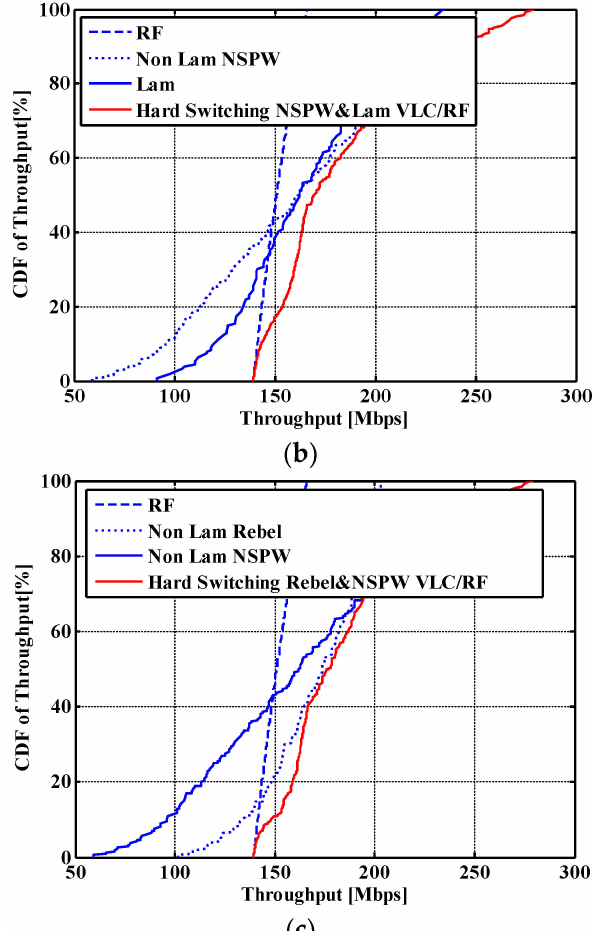
Figure 12. CDF of hybrid VLC/RF link throughput spatial distribution for ( a ) switchable Lambertian and LUXEON Rebel optical beam configuration, ( b ) switchable Lambertian and asymmetric NSPW optical beam configuration, and ( c ) switchable LUXEON Rebel and asymmetric NSPW optical beam